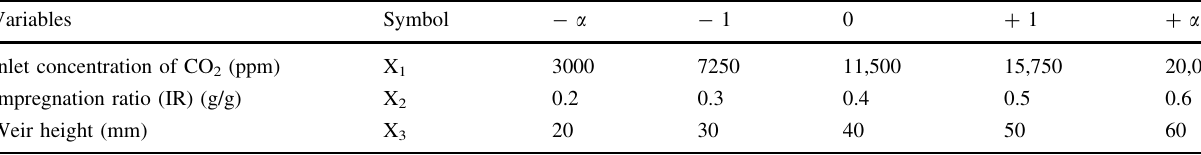
Table 2 Experimental range and levels of independent variables